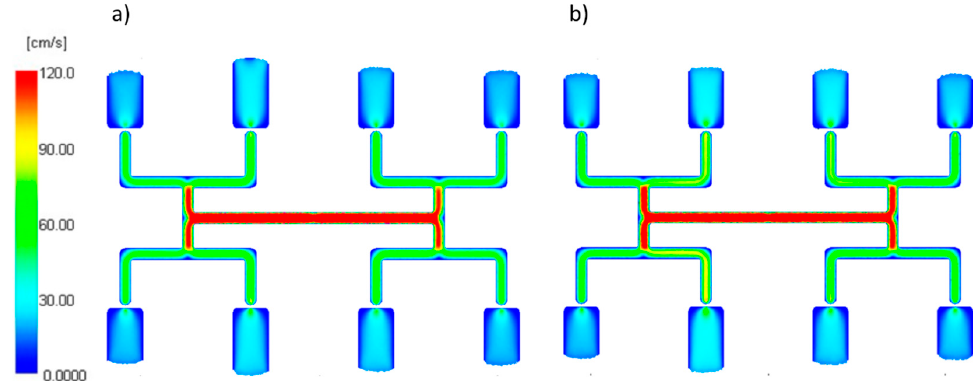
Figure 20. Velocity distribution for different heat transfer coefficient at high injection rate: ( a ) h = 5 W/(m 2 K), and ( b ) h = 50,000 W/(m 2 K).